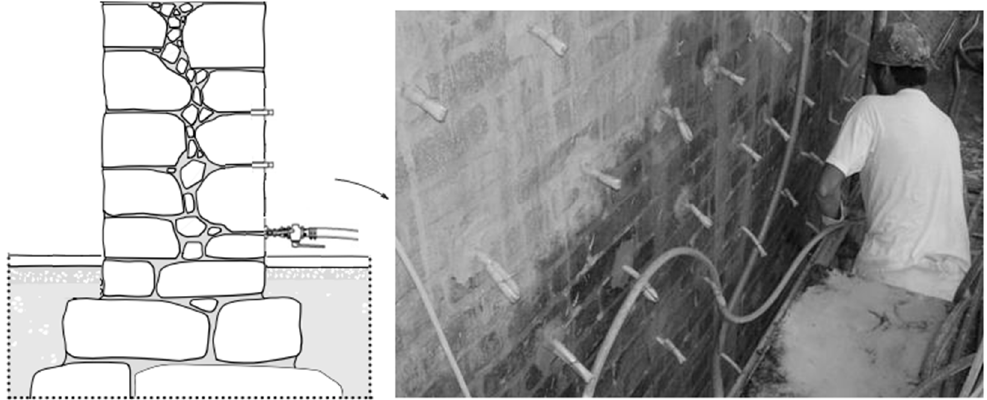
Figure 1. Detail of the grout injection on a stone masonry wall.